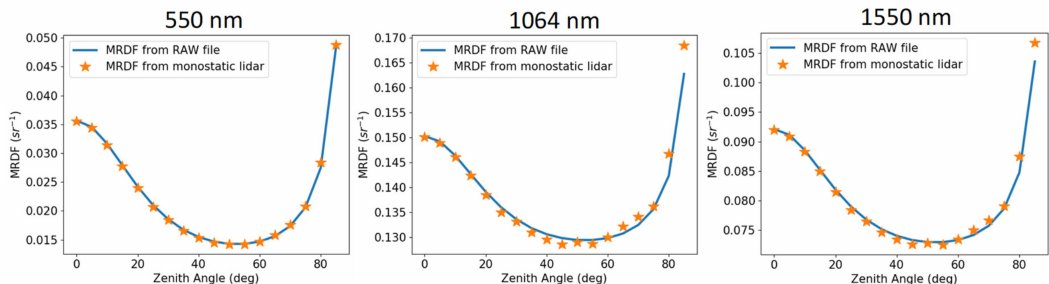
Figure 4. Comparison of monodirectional reflectance distribution function (MRDF) seen from a simulated lidar in DIRSIG, scanning at 5 ◦ zenith steps and capturing the backscatter from 0 ◦ to 85 ◦ zenith angles of a modeled flat plate. The resulting MRDF is compared to the input raw file, defining the bidirectional scattering distribution function (BSDF) properties of the plate, at equivalent data point locations. The comparison was accomplished at 500, 1064, and 1550 nm, as seen in the plots from left-to-right.